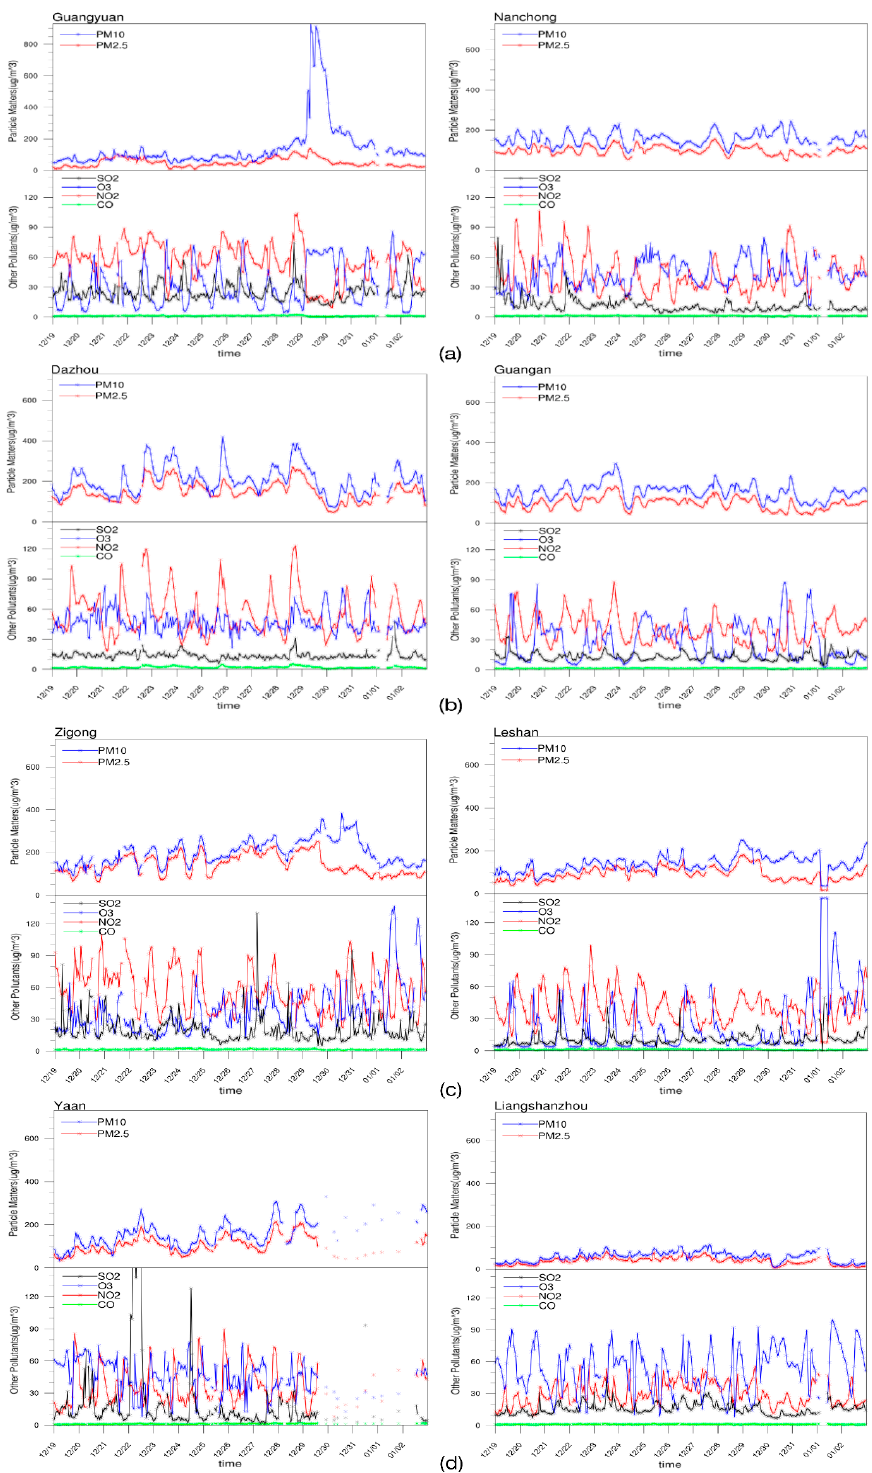
Figure 3. The time series of the concentration of particulate matter (PM 10 and PM 2.5 ) and other pollutants (SO 2 , O 3 , NO 2 , and CO 2 ) in the eight selected cities in northern Sichuan ( a ), eastern Sichuan ( b ), southern Sichuan ( c ) and western Sichuan ( d ) during the pollution episode.